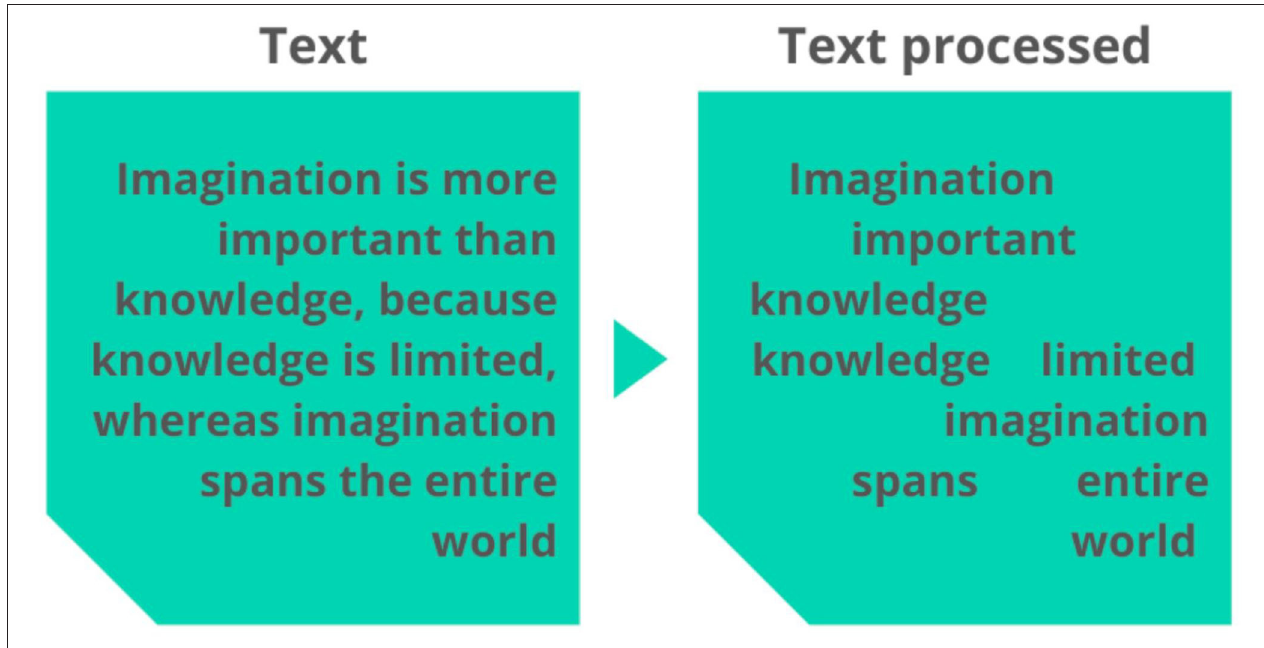
FIGURE 1 | Example of word